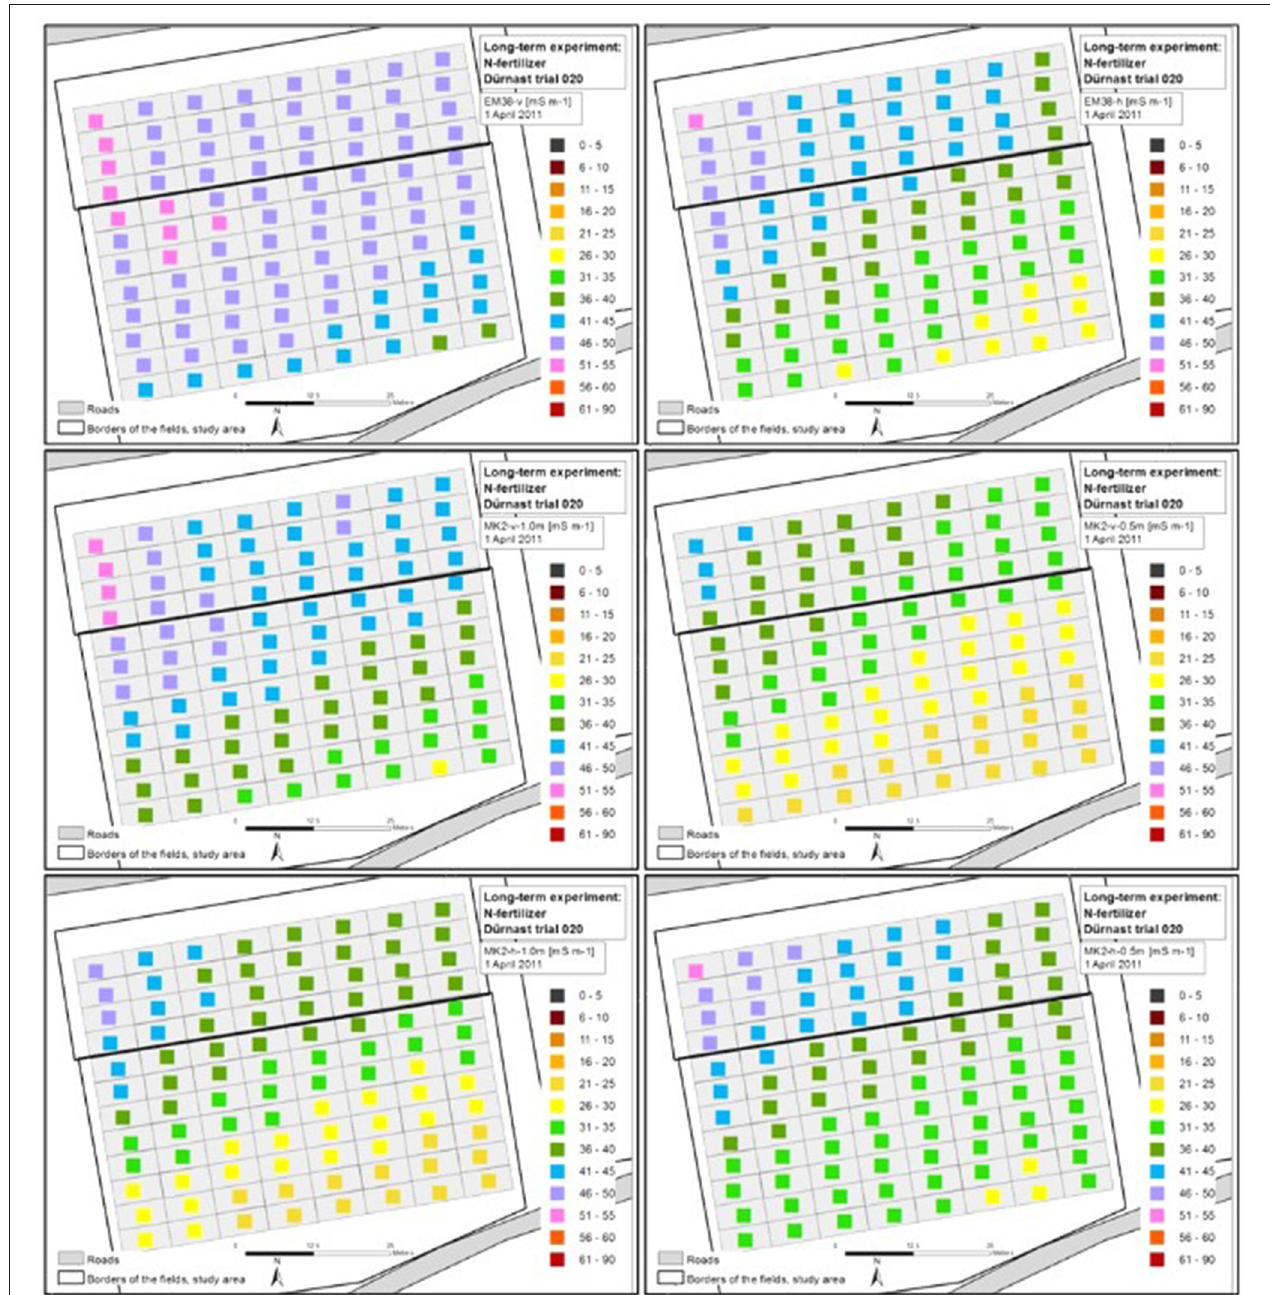
FIGURE 6 | Plot wise EC a readings (mS m − 1 ) from both devices EM38 and MK2 in the configurations vertical, horizontal, 0.5, and 1.0m of the field experiment